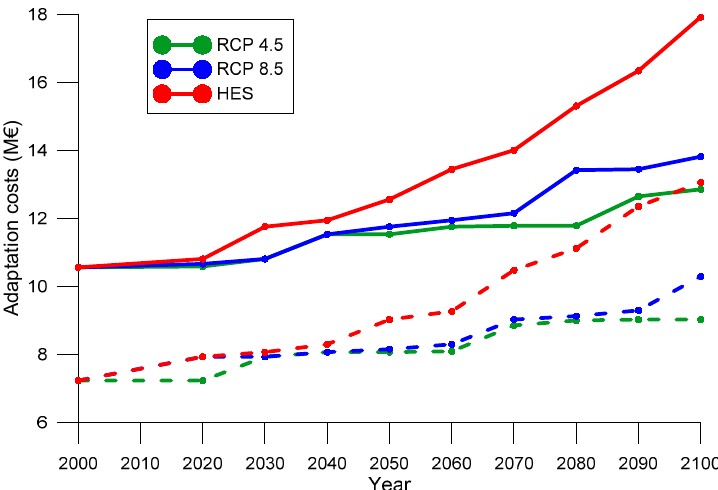
Table 2. Damage and adaptation costs (in M€) for TR = 5 years. DD: Direct damages; AC0D: adaptation costs with 0 damage; ACMD: adaptation costs with minimum damage. Figure 8. Estimation of adaptation costs (in millions of euros) of Catalan ports to overtopping for the three SLR scenarios and for a return period of 50 years. Filled lines indicate the cost of zero damage option and dashed lines correspond to the costs of minimum damage alternative.